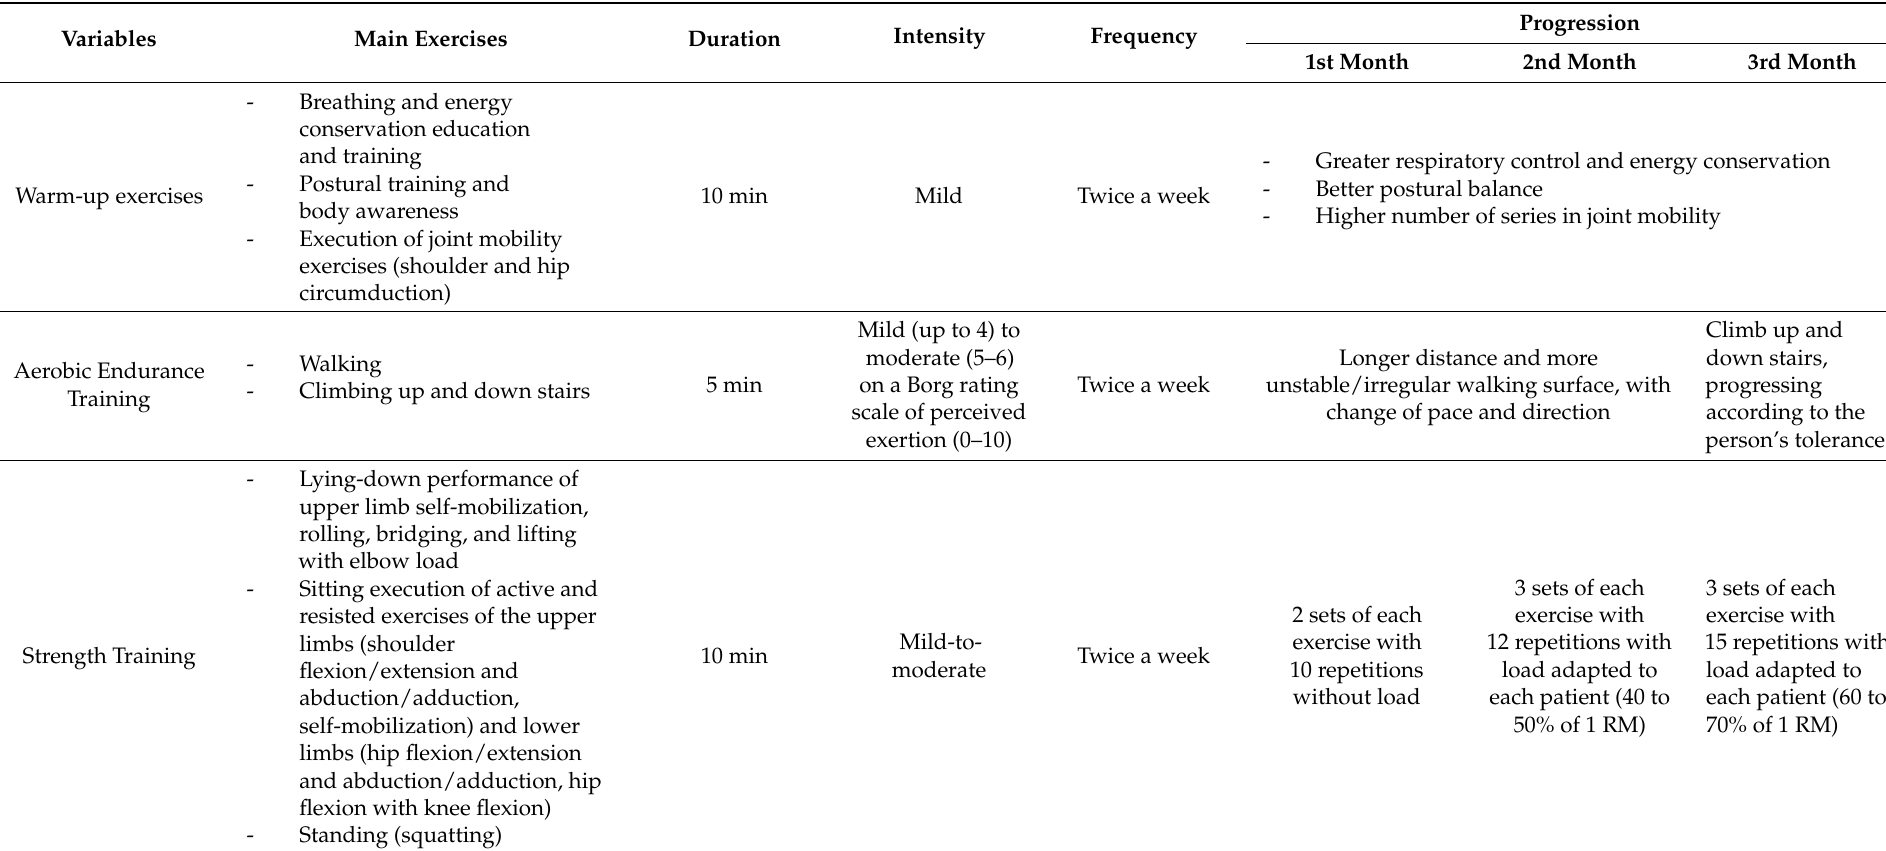
Table 1. Description of the Active Aging in Place–Rehabilitation Nursing Program